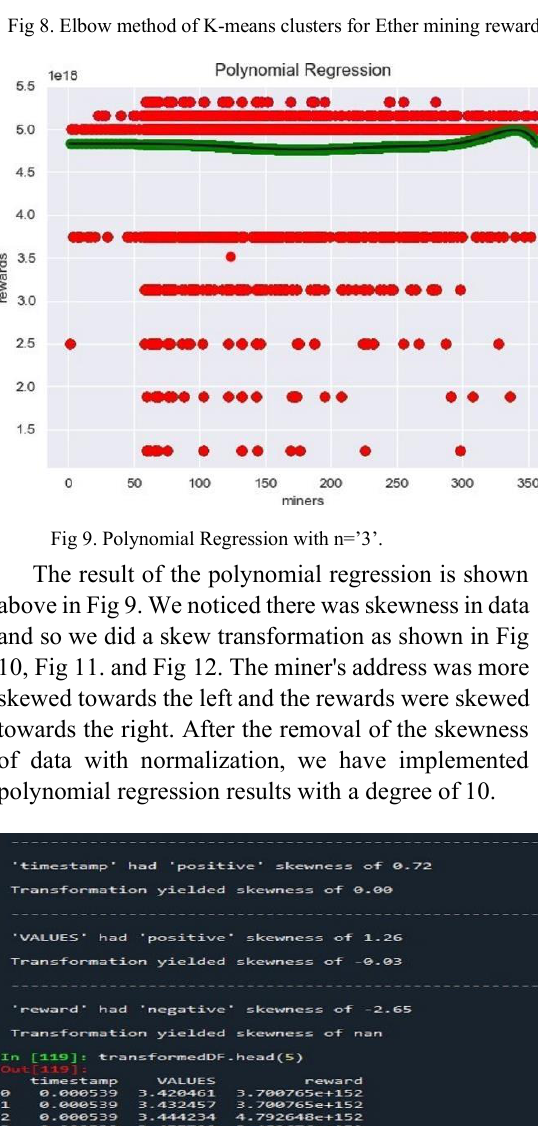
Fig.7. Three clusters with reward and values.